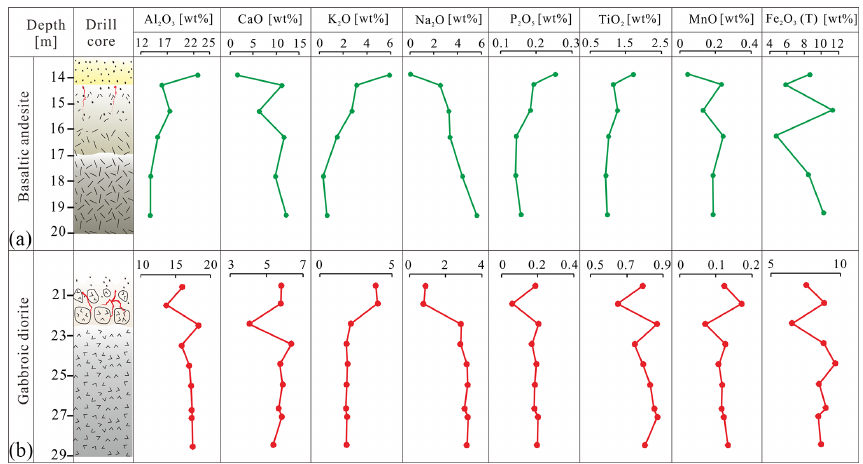
Figure 5. Major element content (in wt%) of the basaltic andesite (a) and the gabbroic diorite (b) along the drill core profile.